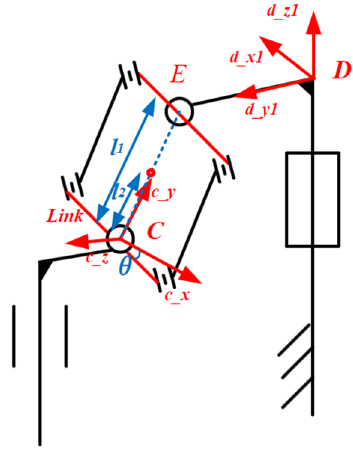
Figure 7. Coordinate system of the upper kinematic chain.